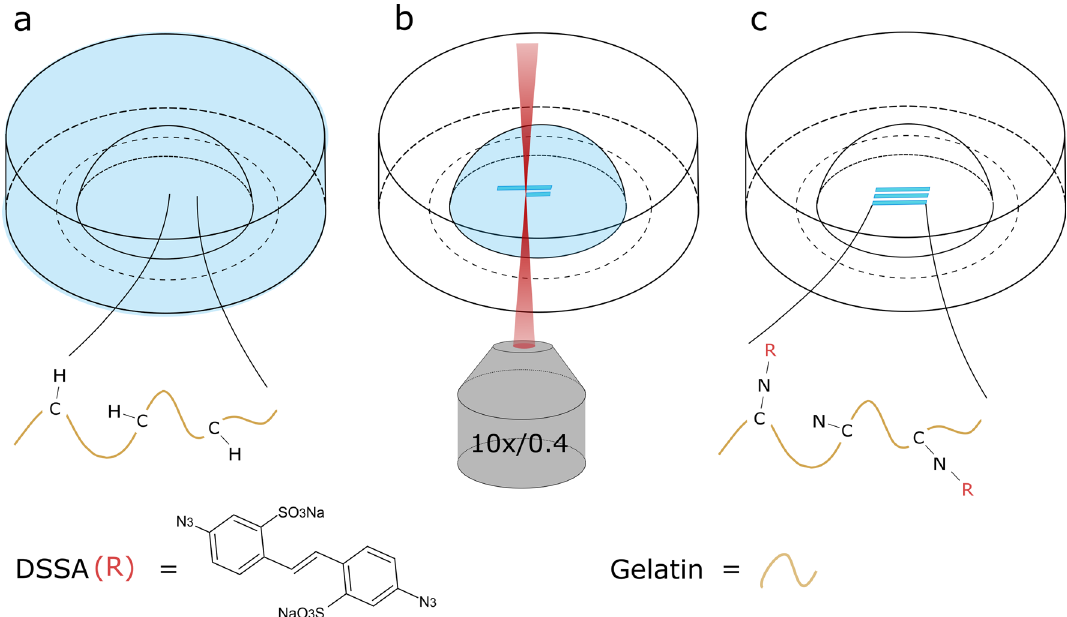
Figure 1. Schematic illustration of the DSSA multi-photon photografting process. ( a ) The UV-crosslinked gel-MA hydrogel pellet is soaked in a DSSA solution for 24 h. ( b ) Upon laser irradiation the azido group is group is photochemically decomposed into reactive nitrenes, ( c ) which covalently bind to C–H groups of gel-MA.